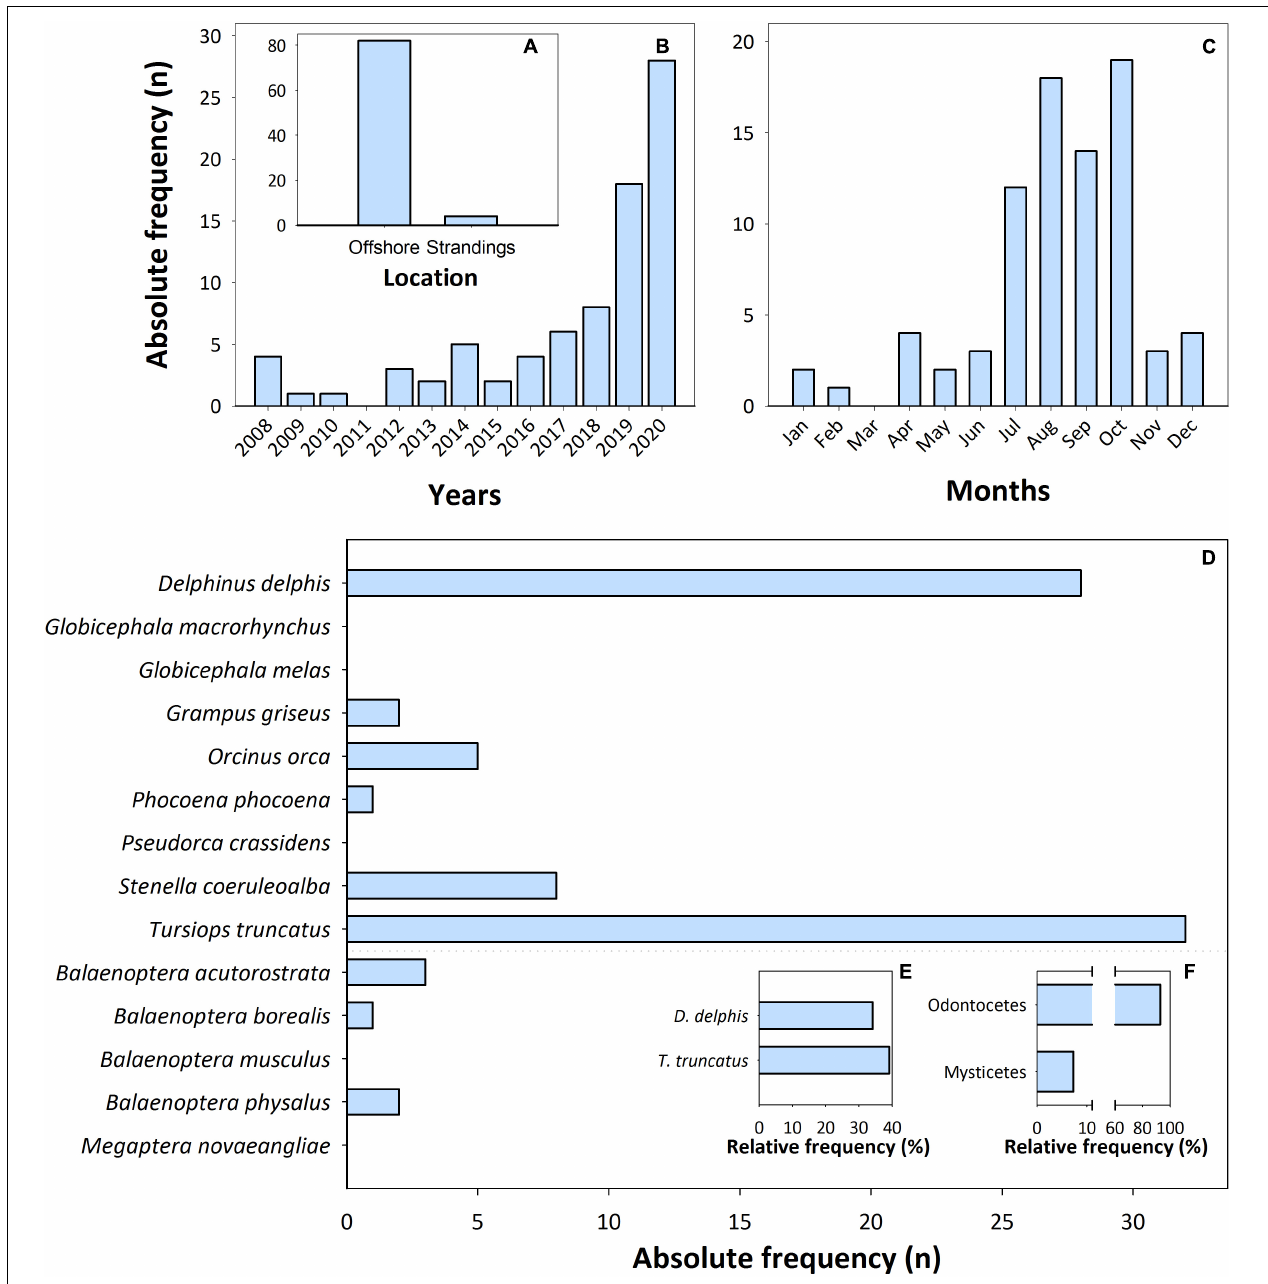
FIGURE 6 | Number of records of cetaceans observed offshore or stranded in the Algarve (Portugal) (A) published between 2008 and 2020 on Biodiversity4All, as well as the total number of records made in each year (B) , month (C) , and of each species (D) . The relative frequency of Delphinus delphis and Tursiops truncatus in the Algarve (E) , as well as of odontocetes and mysticetes (F) , are shown in the inset